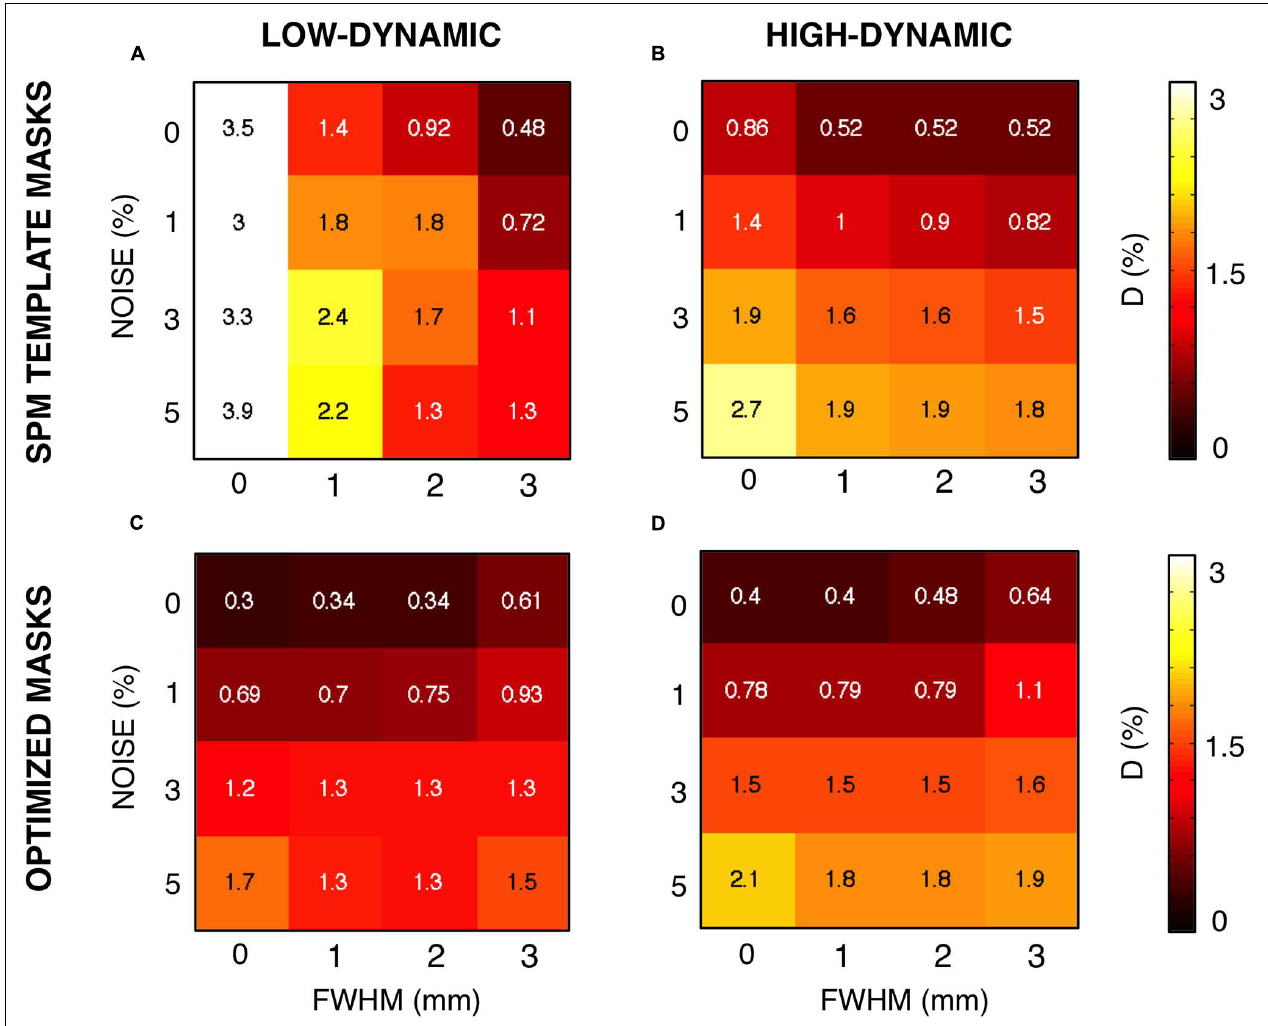
FIGURE 7 | Coefficient of joint variation (CJV) results obtained using optimized and standard masks. We assessed the impact of the masks on the CJV results, expressed in terms of the voxel-wise distance D between the simulated and the estimated INU fields. Specifically, we compared the results obtained using the MNI template masks (A,B) and the optimized masks (C,D) . We examined the performance for different noise level and smoothing, both for low- (A,C) and high-dynamic (B,D) INU